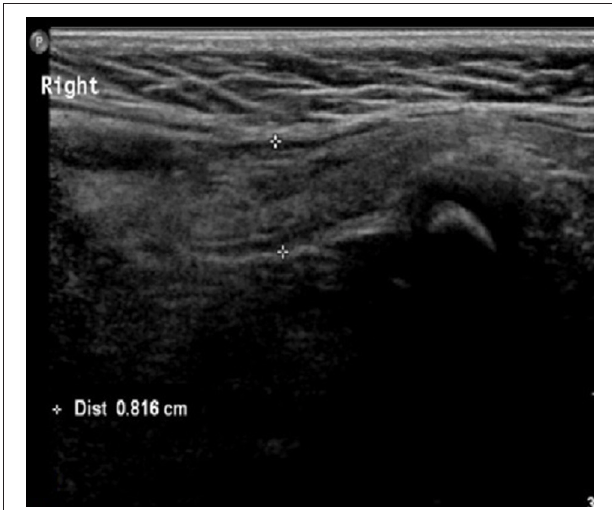
FIGURE 3 | Diameter of the hernia-sided spermatic cord.